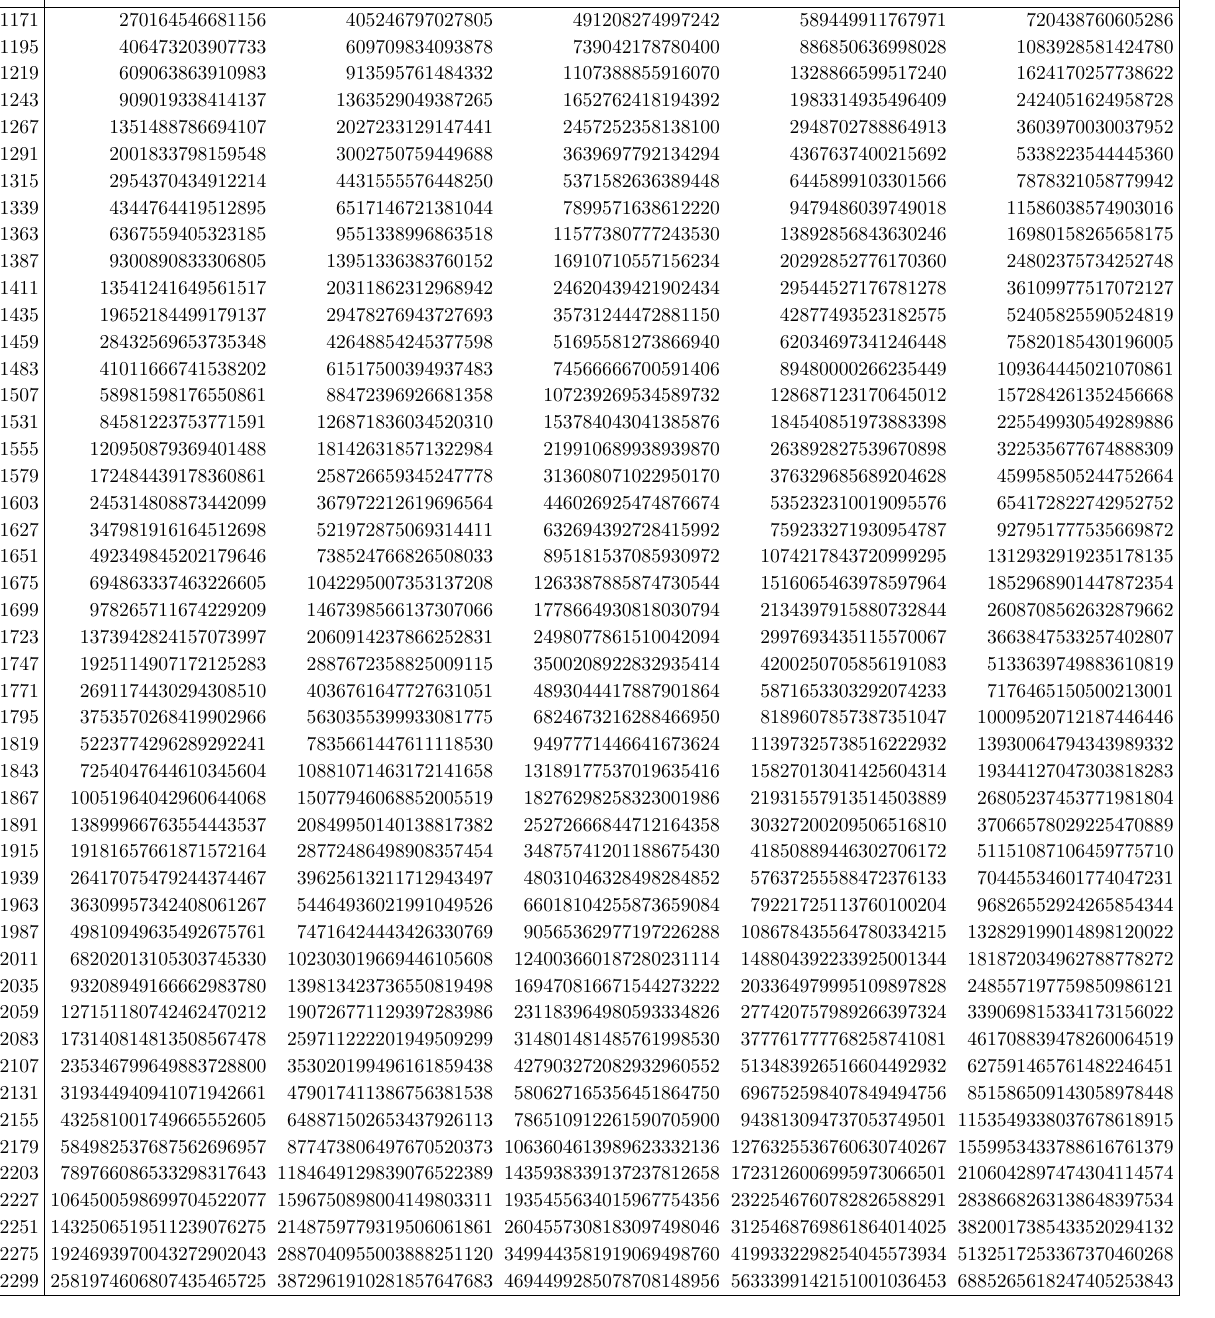
Table 8 . Multiplicity generating functions f (1)